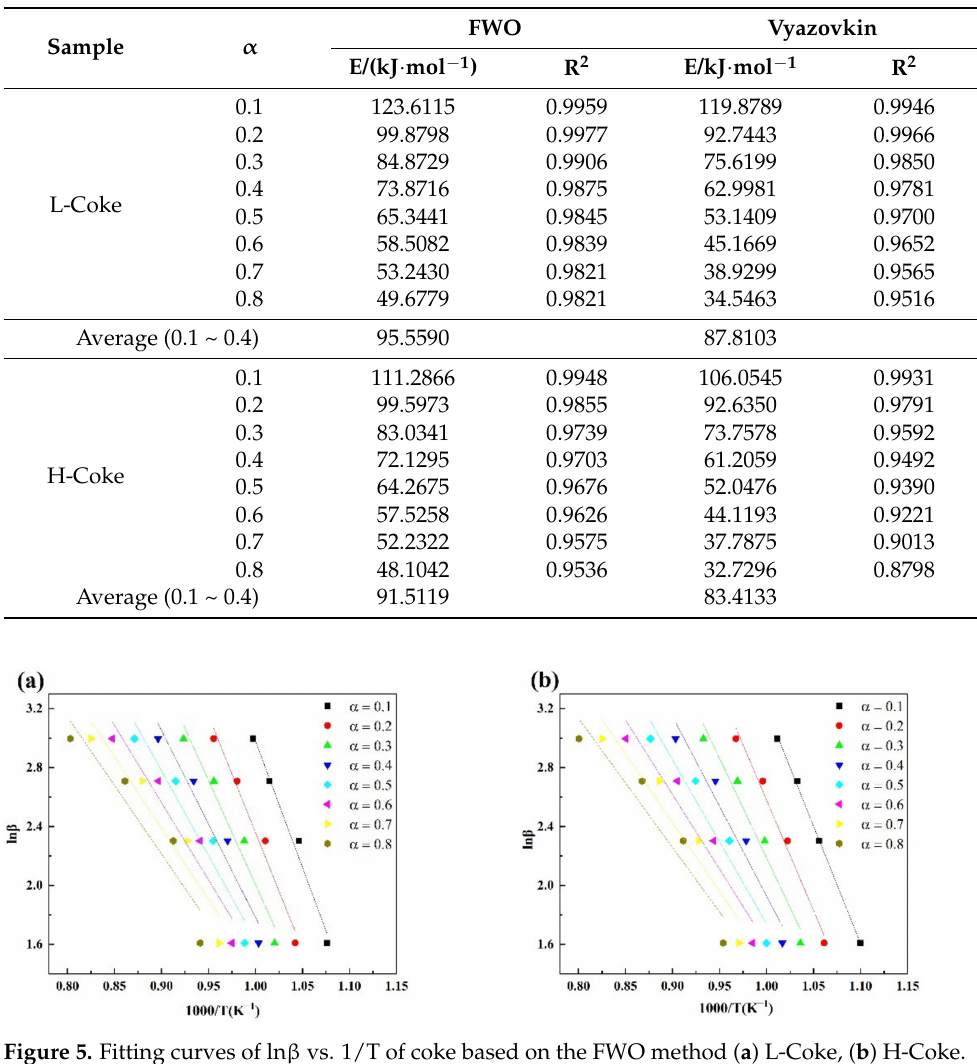
Figure 5. Fitting curves of ln β vs. 1/T of coke based on the FWO method ( a ) L-Coke, ( b )